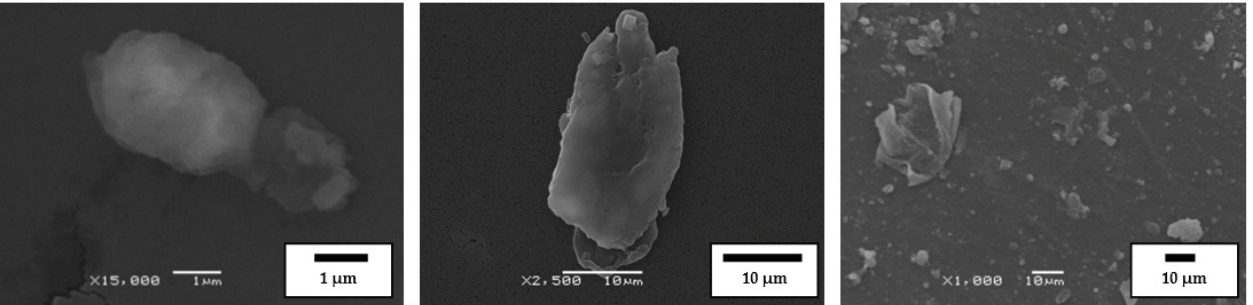
Figure 5. SEM images of characteristic fragments of rubber particles in the form of films on the filter after washing bitumen from MB, prepared under conditions of 120 °C/1 min/manual stirring.